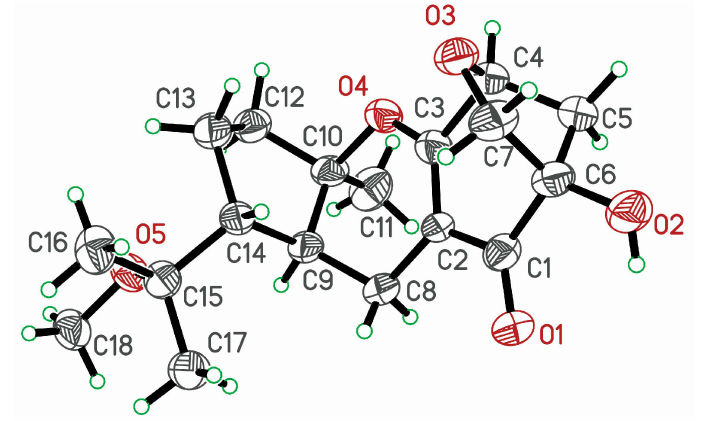
Figure 3. ORTEP diagram of compound 1 .